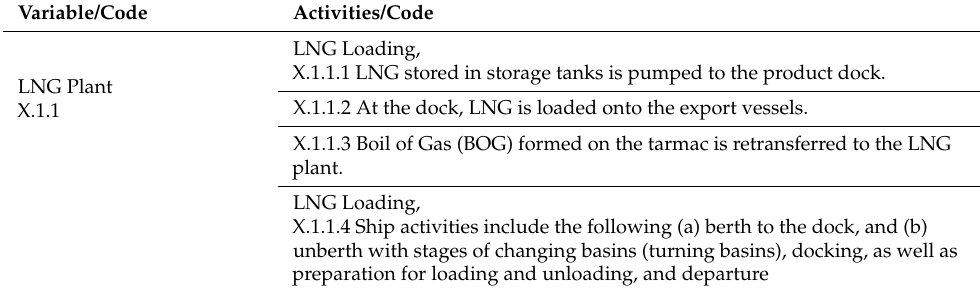
Table 1. LNG Supply Chain